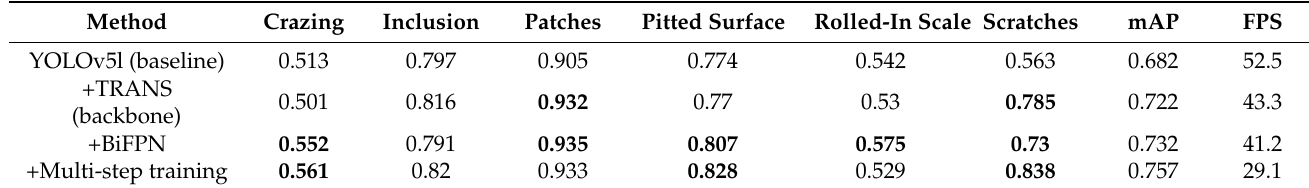
Table 3. Ablation study on